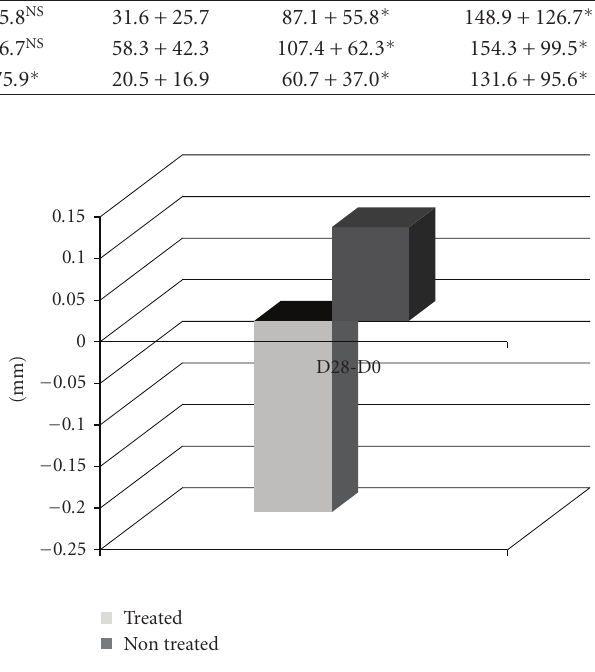
Figure 2: Variation related to D0 of the total cutaneous thickness for each evaluation area